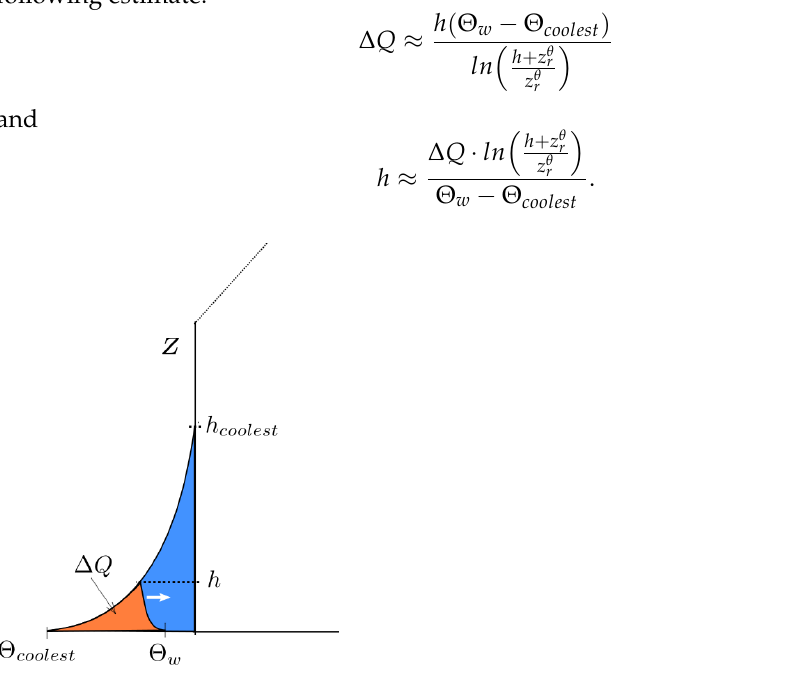
Figure 2. Single-cell model schematics. Heating phase. Dotted line shows the height of a growing mixed layer. White arrow shows the direction of a daytime temperature profile